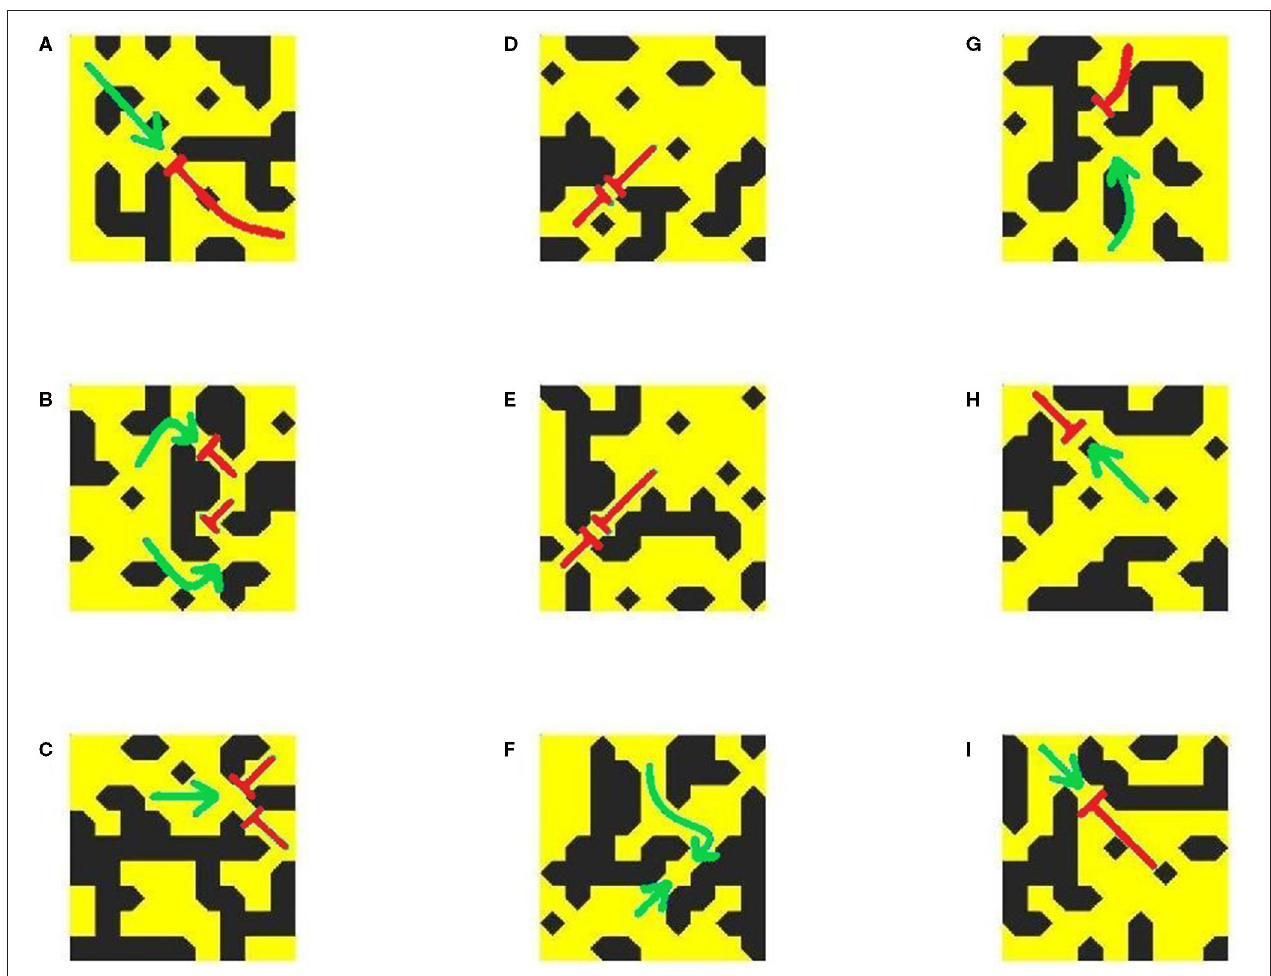
FIGURE 9 | Conduction patterns in completely unseen structures from new simulations, and the corresponding predictions of the classifier model. Shown are examples of correctly identified pro-arrhythmic (A–C) and non-arrhythmogenic (D–F) micropatterns, and undetected pro-arrhythmic (G–I) micropatterns. All are of size 9 × 9 elements. Green arrows indicate the directions of AP propagation, with red flat arrowheads indicating conduction block. Notably, the classifier model can successfully identify structures that result in a complete block from all directions (D,E) but could not successfully identify all pro-arrhythmic structures, particularly those where block occurs near the micropattern boundary (H,I)